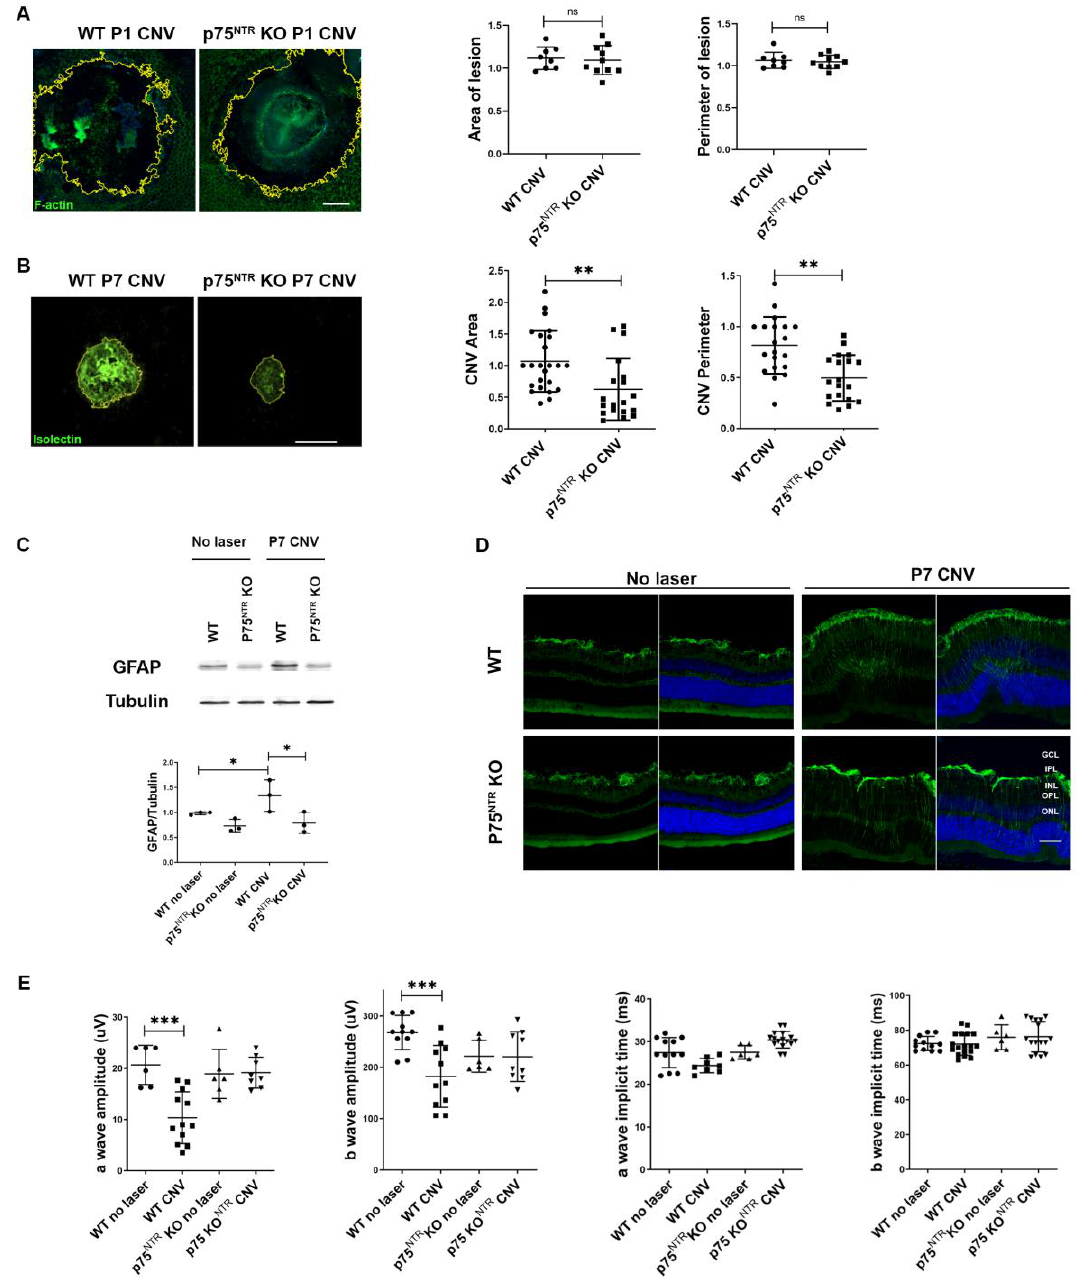
Figure 4. Reduced neovascular phenotype in the choroid of p75 NTR knockout mice, after laser injury. The area and the perimeter of choroidal neovessels are significantly reduced in RPE-Choroid flat-mounts of p75 NTR KO mice. ( A ) Representative confocal images of RPE-Choroid flat-mounts of WT and p75 NTR KO mice 1 day after laser injury, showing immunofluorescence staining with Falloidin (green). The yellow outline represents the lesioned area estimated by F-actin negative staining. Scale bar: 15 µ m. Cell nuclei counterstained with Hoechst are also shown (blue). The area and perimeter of the laser lesion were quantified with ImageJ FIJI software, and represented in the bar graph expressed as units relative to WT CNV control. Bars denote the mean ± SD from triplicate experiments, n = 4 mice/group. ns: non-significant. ( B ) Representative confocal images of RPE-Choroid flat-mounts of WT mice 7 days after laser injury, showing immunofluorescence staining with Isolectin IB-4 (green). The yellow outline represents the neovessels covered area. Scale bar: 200 µ m. The area and the perimeter of the neovessels were quantified with ImageJ FIJI software,